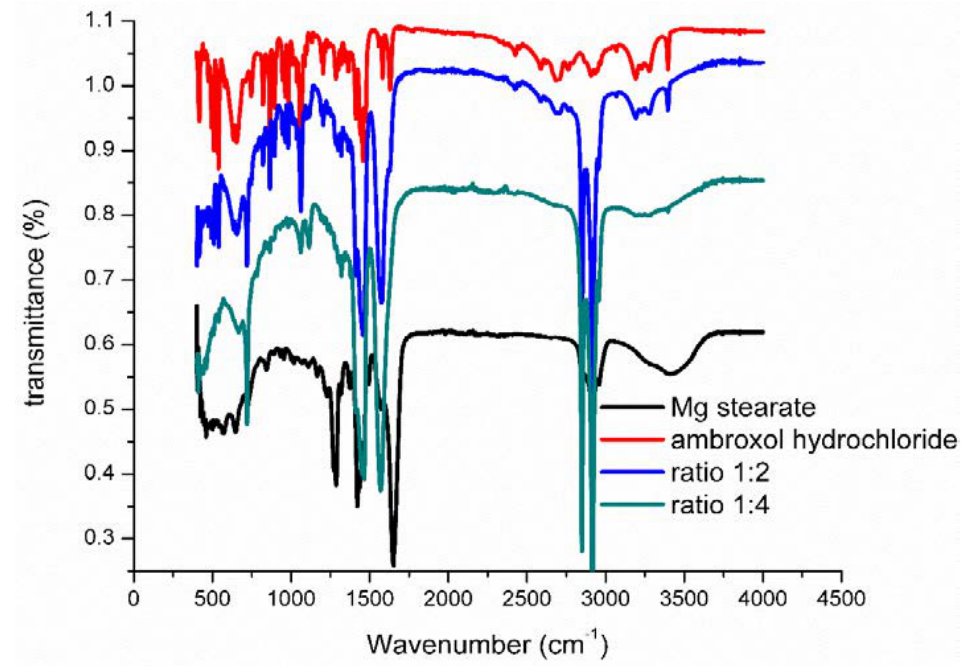
Figure A1. FTIR spectra of pure AMB, PVP, and AMB/PVP mixture in 1:2 and 1:4 ratio.